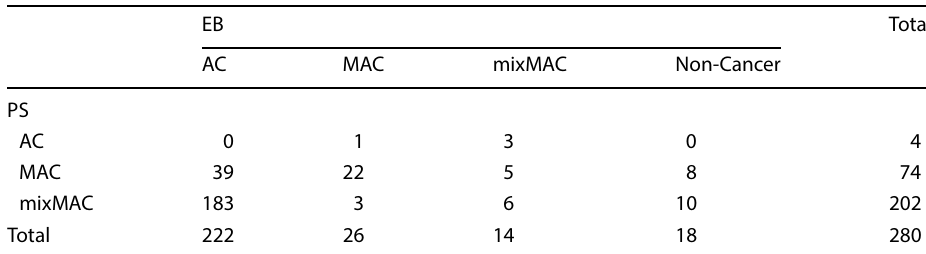
Table 2 The crosslinking table of endoscopic biopsy and postoperative specimen diagnosis of